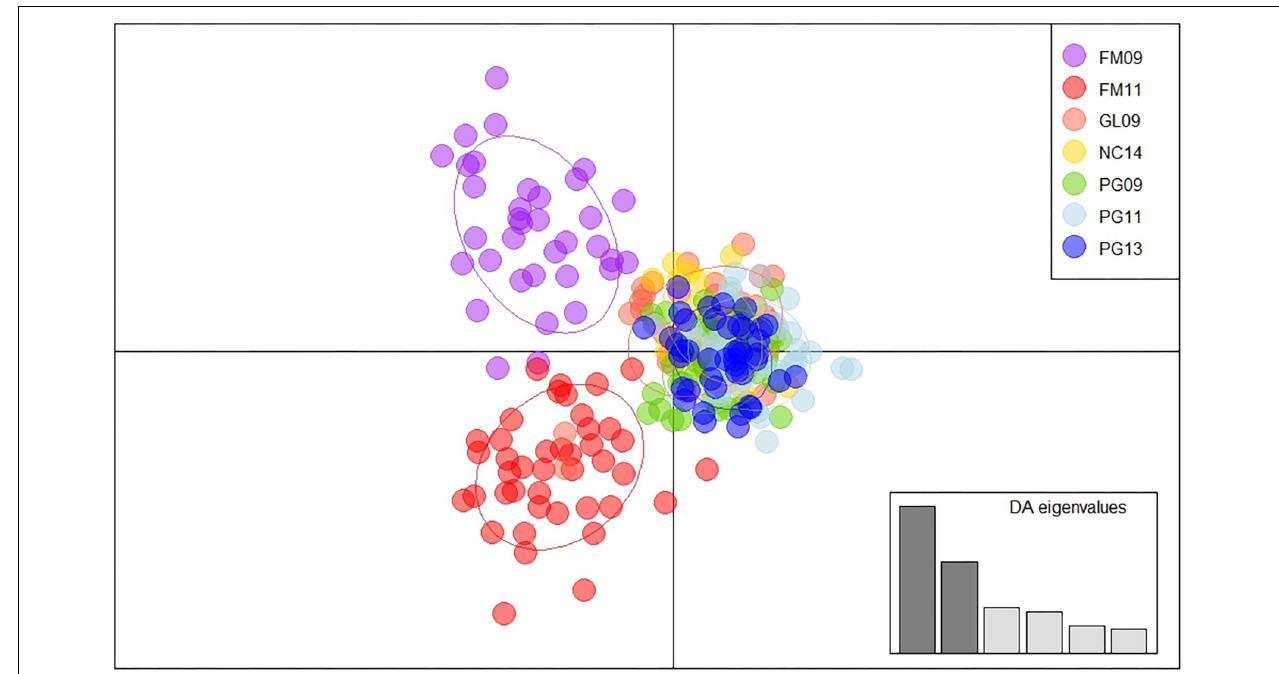
FIGURE 2 | Discriminant analysis of principle components using all individuals in their original sample groups. Calculation is alpha-optimized at 62 principle components and 6 degrees of freedom.